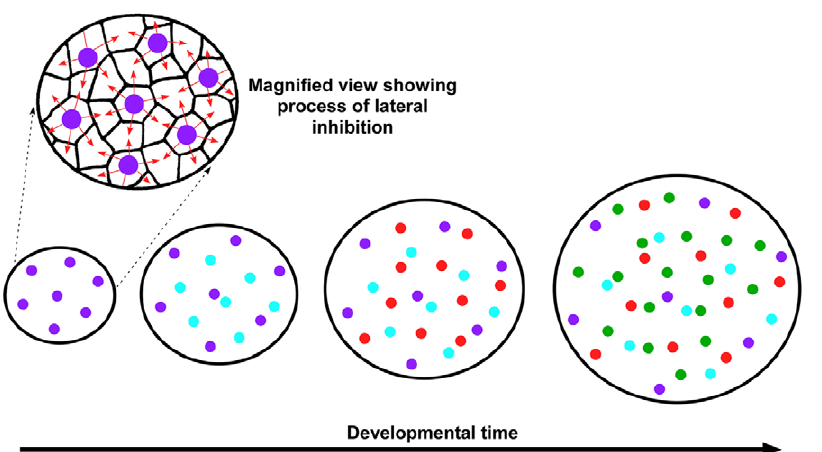
Figure 8. A model for the formation of the photoreceptor mosaics of the chicken. In this model the individual photoreceptor types establish their spacing in a series of temporally discrete waves. The least abundant photoreceptor type (i.e., violet cones) establishes spacing first, possibly via a lateral inhibition mechanism (far left). Then, the next most abundant photoreceptor type, blue cones, establishes its spacing. This process continues until spacing has been established for all photoreceptor types (the diagram only shows the four single cone types). The addition of subsequent waves of photoreceptors results in a relatively uniform expansion of the epithelium and a concomitant ‘spacing out’ of those photoreceptor types whose spacing was established earlier. Since spacing is established in discrete steps, all photoreceptor types can, in principle, employ the same biochemical mechanism to establish spacing.